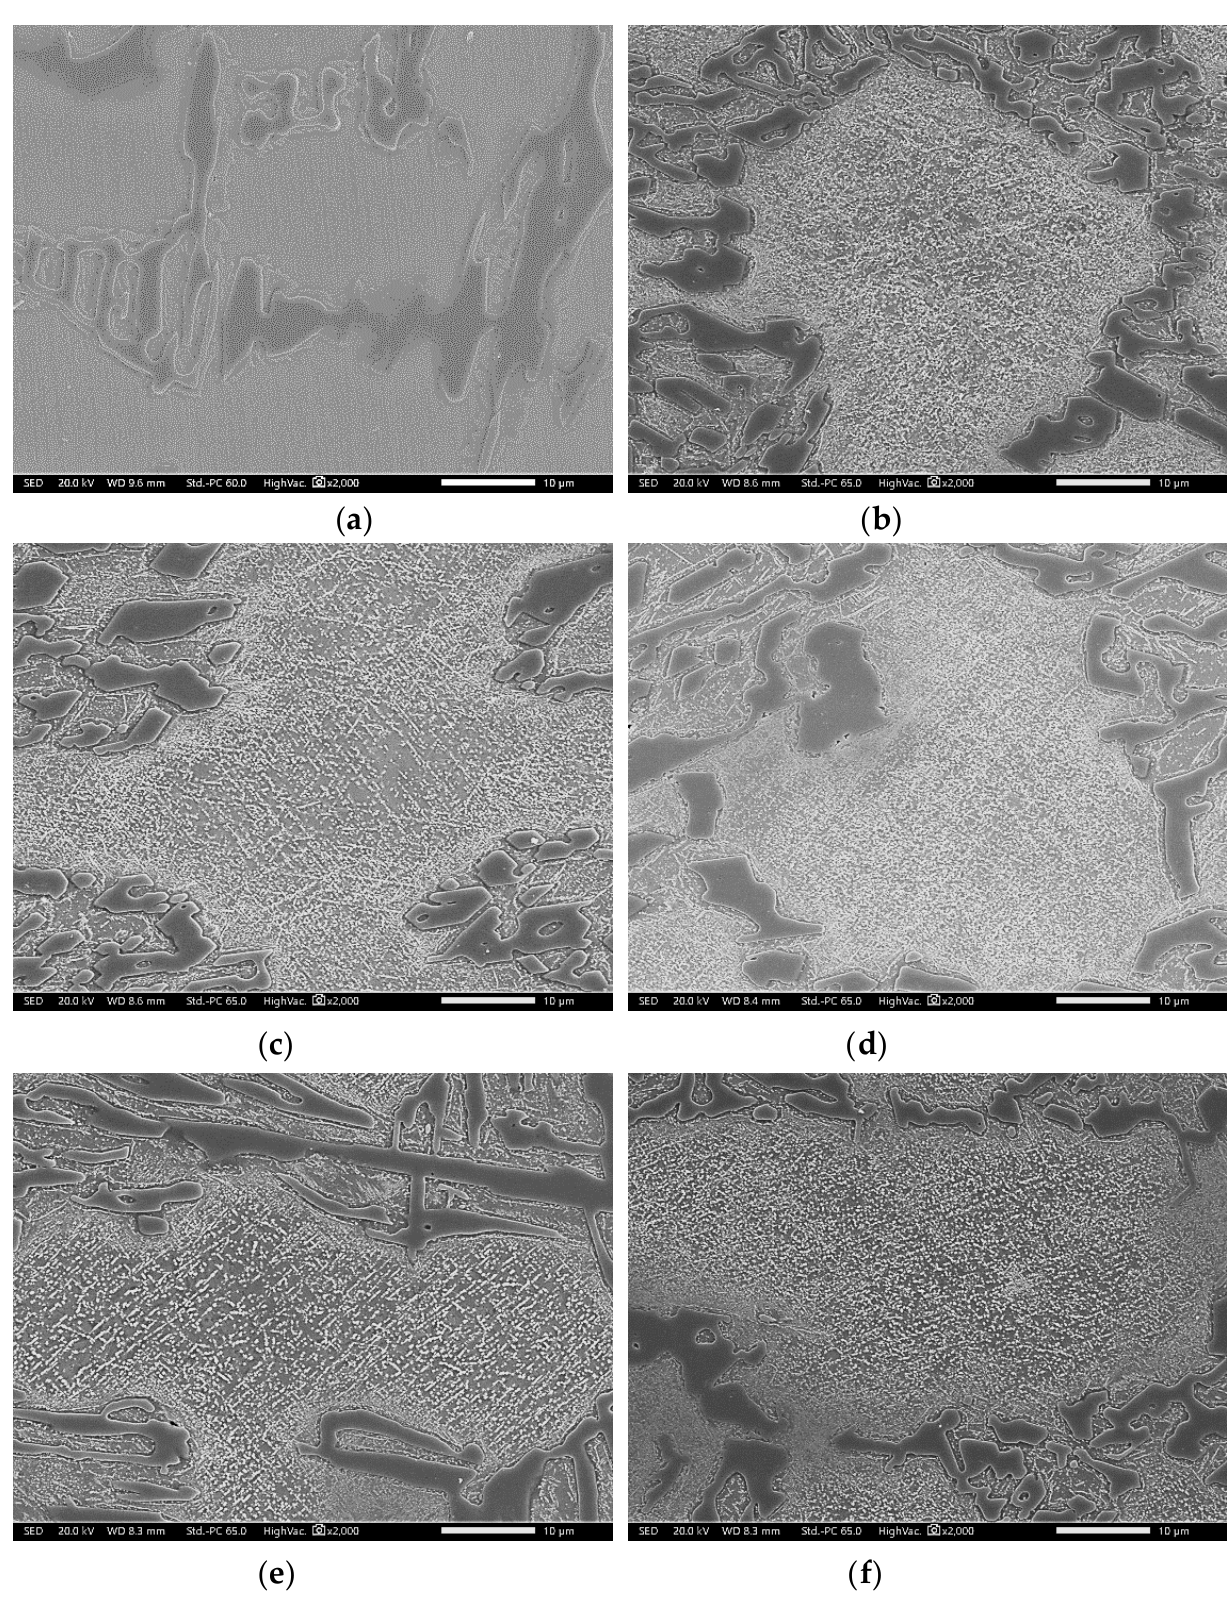
Figure 14. Effect of soaking time at 890 °C on the microstructural evolution of 2127 alloy: ( a ) as cast; ( b ) 10 min; ( c ) 30 min; ( d ) 60 min; ( e ) 240 min; ( f ) 300 min.